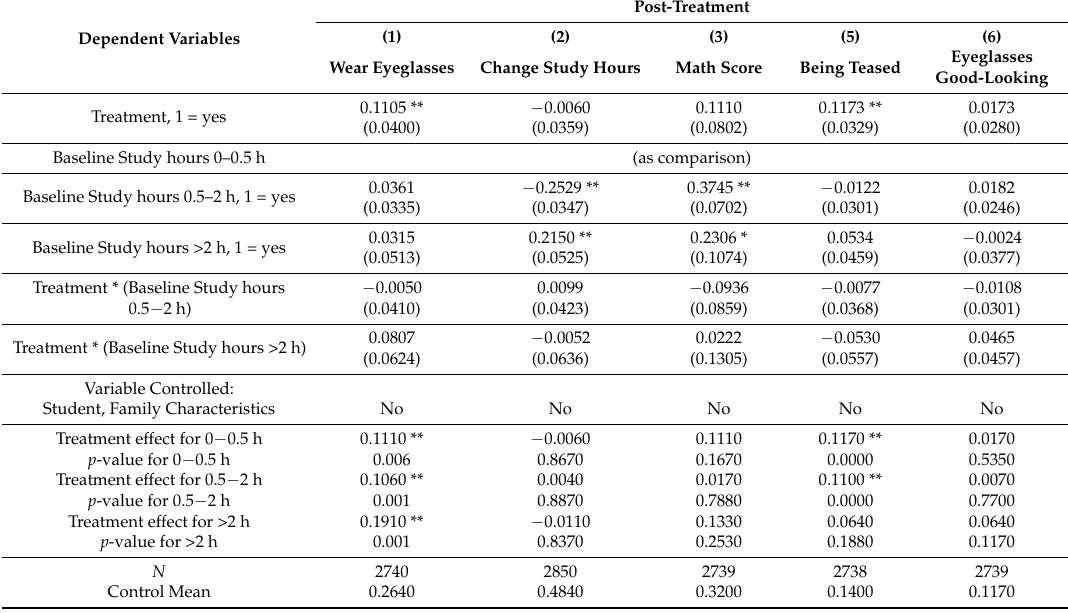
Table A5. Impact of Providing Fully Subsidized Eyeglasses on Secondary Outcomes by Daily After-class Study Time (without